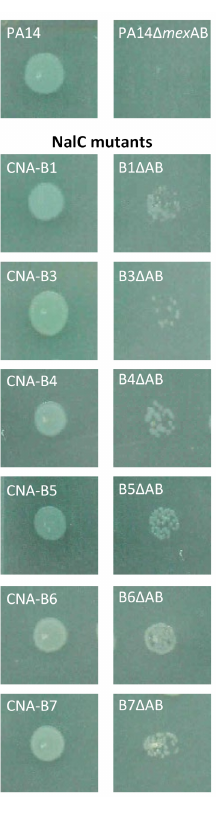
Figure 1. Impact of genes mexAB deletion on resistance to CNA. Genes mexAB were deleted in PA14 (CNA MIC before deletion equal to 700 µ g/mL), and CNA-resistant nalC mutants CNA-B1, B3, and B5 (1000 µ g/mL), and CNA-B4, B6, B7 (1100 µ g/mL). The inactivated mutants ( ∆ AB) and their progenitors were spotted onto the surface of an MHA plate containing 500 µ g/mL